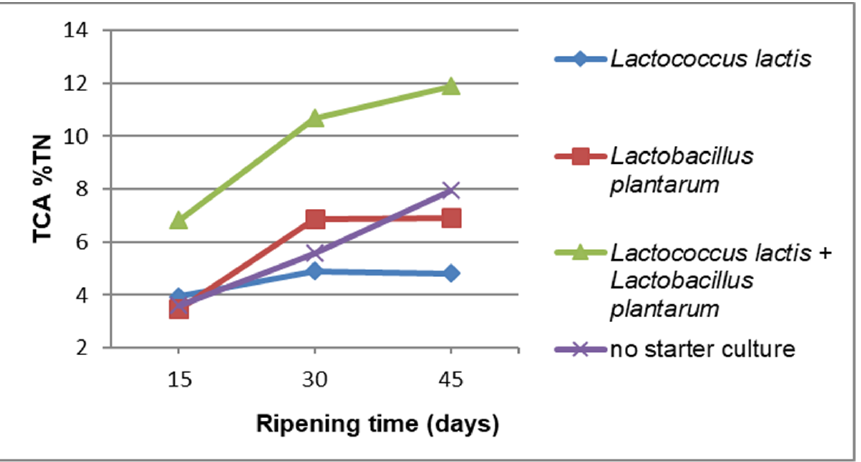
Figure 5. Water-soluble nitrogen fractions in the total nitrogen (WSN %TN) of Sir iz mišine at 15, 30, and 45 days of ripening. Figure 6. The 12%-trichloroacetic-acid-soluble nitrogen fraction in the total nitrogen (TCA-SN %TN) of Sir iz mišine at 15, 30, and 45 days of ripening.